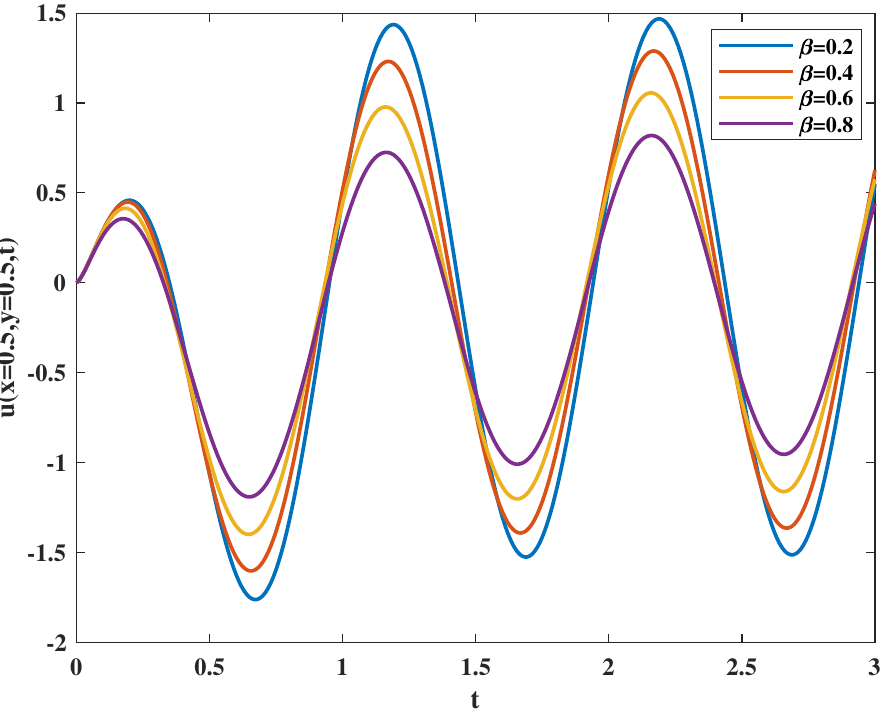
Figure 5. Velocity varies with fractional parameter β